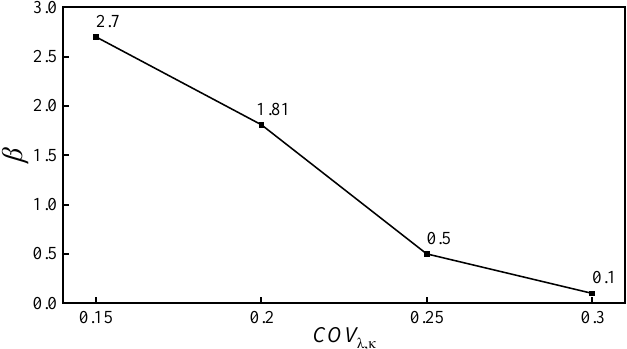
Figure 19. Reliability of ground surface settlement and COV λ , κ .